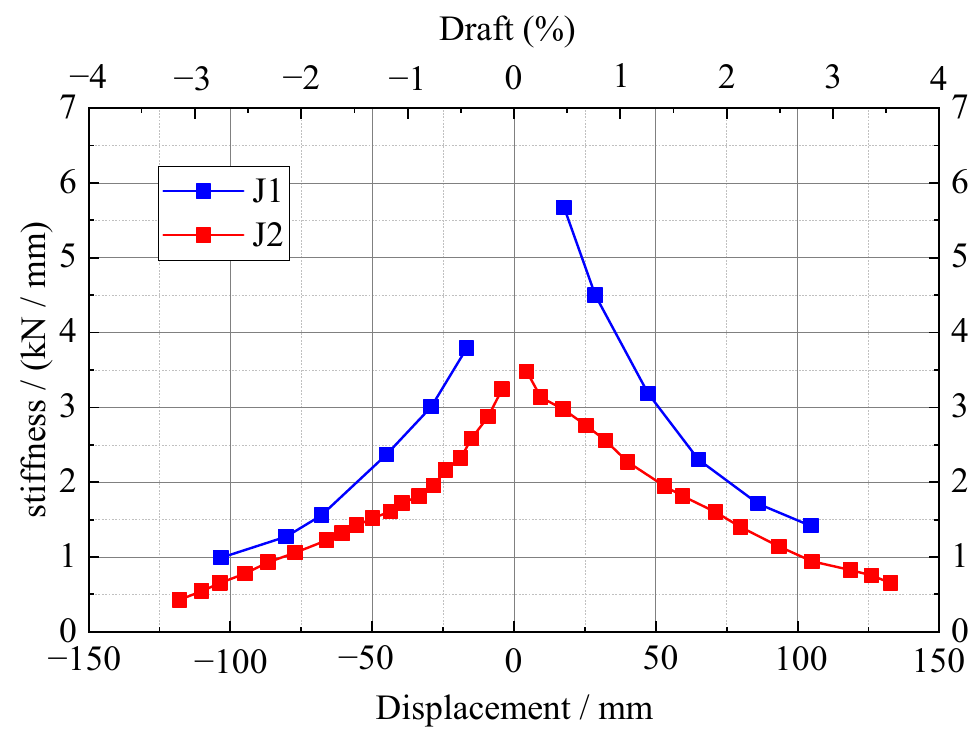
Figure 17. Stiffness degradation curves.